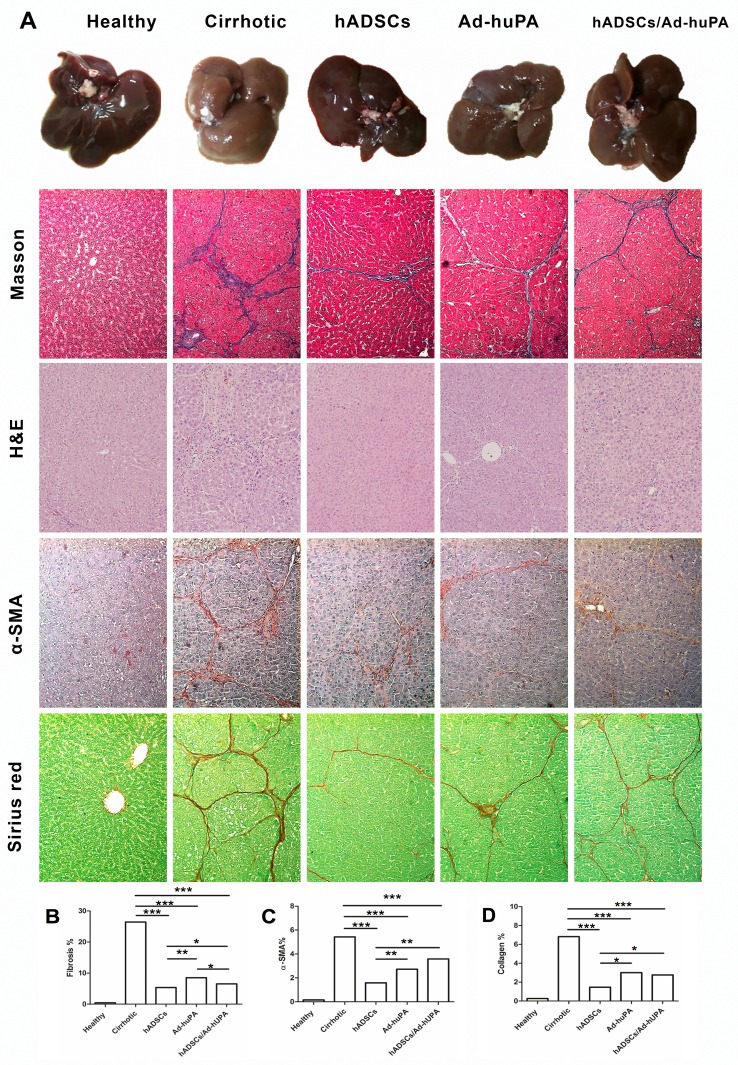
Assessment of liver fibrosis, inflammation, α-SMA and collagen staining in cirrhotic animals treated with cell and gene therapy.(A) Macroscopic appearance of the liver and Masson staining showed characteristic morphological liver alterations in cirrhotic rats. Animals treated with any of the therapies showed reduction of fibrotic tissue and decrease in inflammatory cell infiltrate in H&E-stained liver. IHC for α-SMA revealed decrease in staining in treated animals. Sirius red staining indicates a reduction in liver collagen content in animals that received treatment. (B) Fibrosis percentage in liver tissue was measured in control and treated rats (C) Quantification of α-SMA immunoreactivity in liver tissue of treated animals and controls. Data represent the median for each group (*P<0.05, **P<0.01, ***P<0.001). (D) Morphometric quantification of collagen staining using Sirius Red in liver tissue. Data represent the median for each group (*P<0.05, **P<0.01, ***P<0.001).